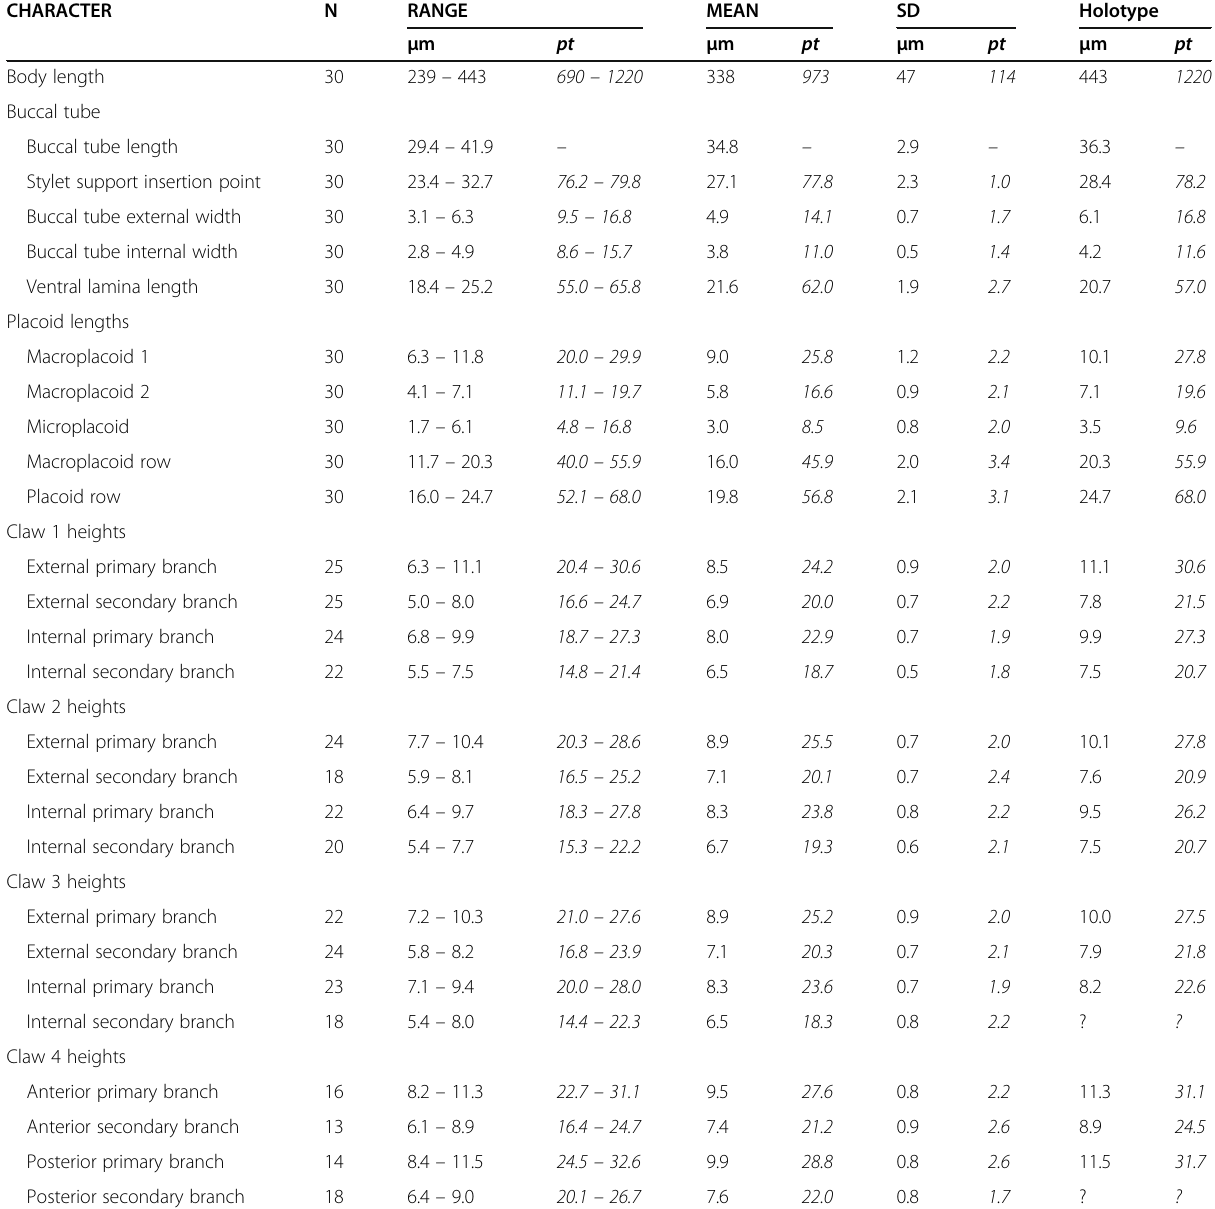
Table 12 Measurements [in μ m] of selected morphological structures of individuals of Macrobiotus margoae sp. nov. from the USA (US.057) mounted in Hoyer ’ s medium (N – number of specimens/structures measured, RANGE refers to the smallest and largest structures among all measured specimens; SD – standard